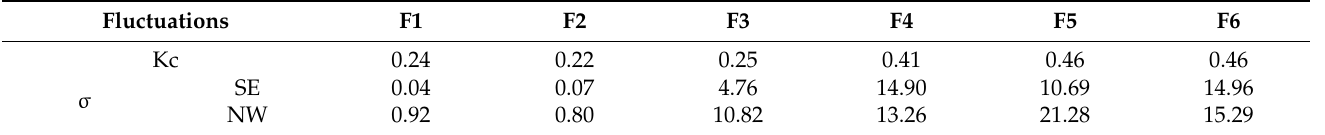
Table 14. The data of the wind speed dispersion and contour tortuosity.